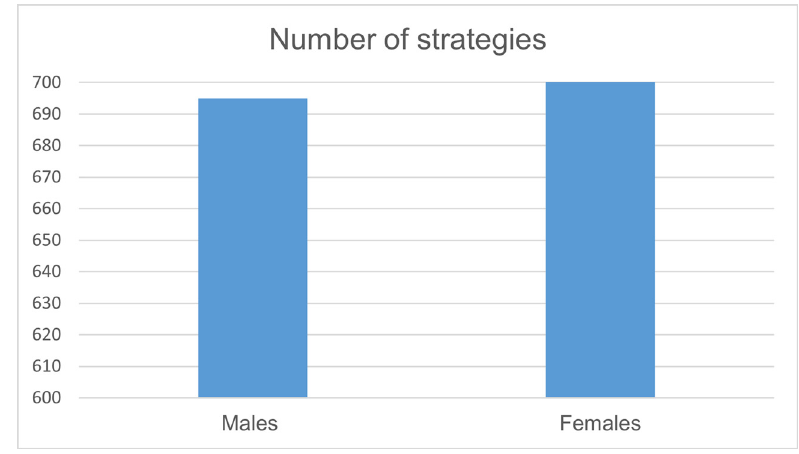
Figure 2: The number of strategies used by females and males for expressing